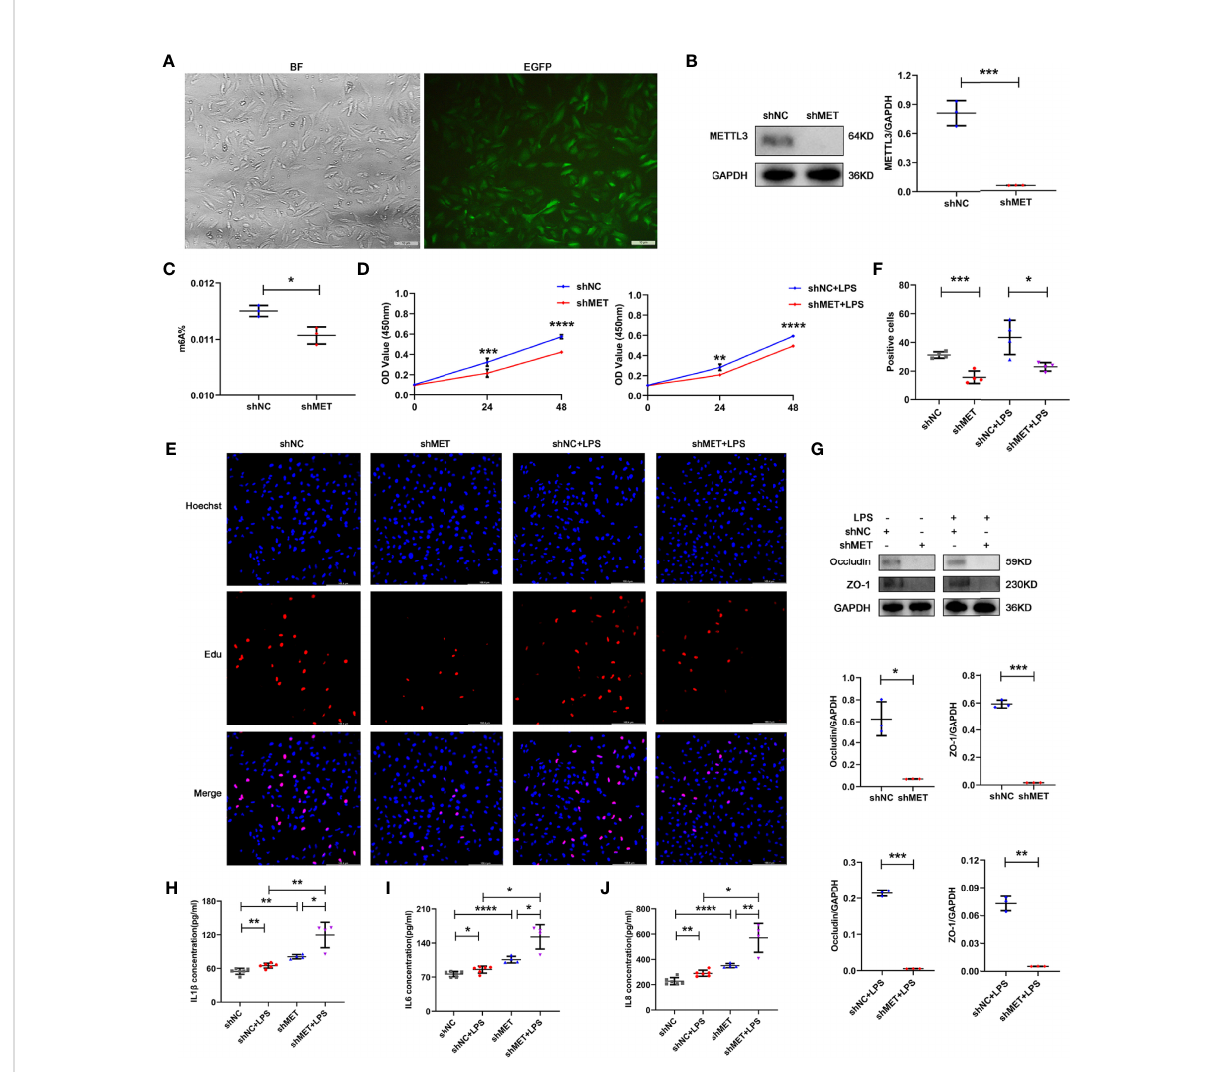
FIGURE 3 Phenotype of ARPE19 cells after silencing METTL3. (A) Transfection ef fi ciency of the METTL3-silenced lentivirus in ARPE19 cells (BF, bright fi eld; EGFP, enhanced green fl uorescence protein; scale bar, 10 m m). (B) Silencing ef fi ciency of METTL3 in ARPE19 cells. Left, representative western blotting images of METTL3. Right, quanti fi cation of relative expression of METTL3 (mean ± SD; *** P<0.001; n=3/group; unpaired Student ’ s t- test). (C) m 6 A% after silencing METTL3 in ARPE19 cells (mean ± SD; * P<0.05; n=3/group; unpaired Student ’ s t-test). (D) Cell viability of ARPE19 cells after silencing METTL3 with or without LPS stimulation (mean ± SD; ** P<0.01, *** P<0.001, **** P<0.0001; n=5-6/group; unpaired Student ’ s t-test). (E, F) Proliferation of ARPE19 cells. (E) Representative Edu images of ARPE19 cells after silencing METTL3 with or without LPS stimulation (scale bar, 166.4 m m). (F) Quanti fi cation of Edu positive cells (mean ± SD; * P<0.05, *** P<0.001; n=4/group; one-way ANOVA). (G) Protein levels of Occludin and ZO-1 in ARPE19 cells after silencing METTL3 with or without LPS stimulation. Upper, representative western blotting images of Occludin and ZO-1. Lower, quanti fi cation of relative expression of Occludin and ZO-1 (mean ± SD; * P<0.05, ** P<0.01, *** P<0.001; n=3/group; unpaired Student ’ s t-test). (H – J) The secretion levels of IL-1 b , IL-6 and IL-8 in ARPE19 cells after silencing METTL3 with or without 24 hours of LPS stimulation (mean ± SD; * P<0.05, ** P<0.01, **** P<0.0001; n=4-6/group; one-way